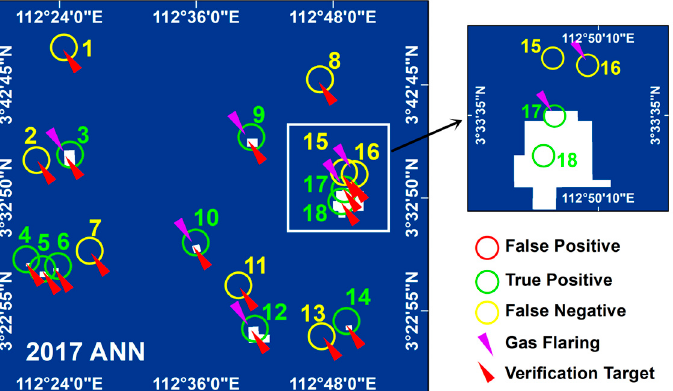
Figure 6. Comparison of the gas flaring data and the 2017 ANN extraction results. Red arrows are the validation targets; purple arrows are the 2017 natural gas flaring products; green circles are the correctly extracted targets; yellow circles are the omissive targets; and red circles are the incorrectly extracted targets.